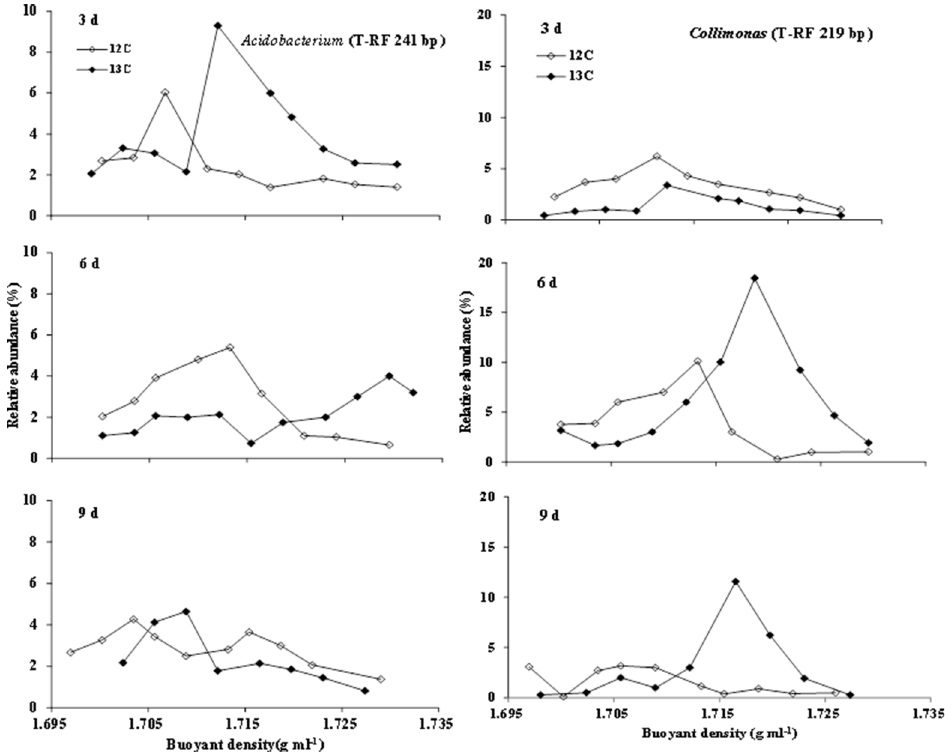
Fig 1. The shift trendency of 241-bp and 219-bp fragments. The relative abundance of the dominant 241-bp and 219-bp fragments over a range ofbuoyant density (BD) from DNA extracted after 3, 6, 9 days from the soil added with either 13 C or 12 C labeled